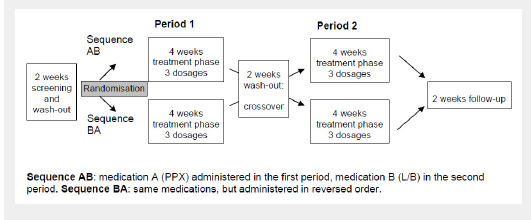
Study design: Randomized, double-blind, comparative crossover